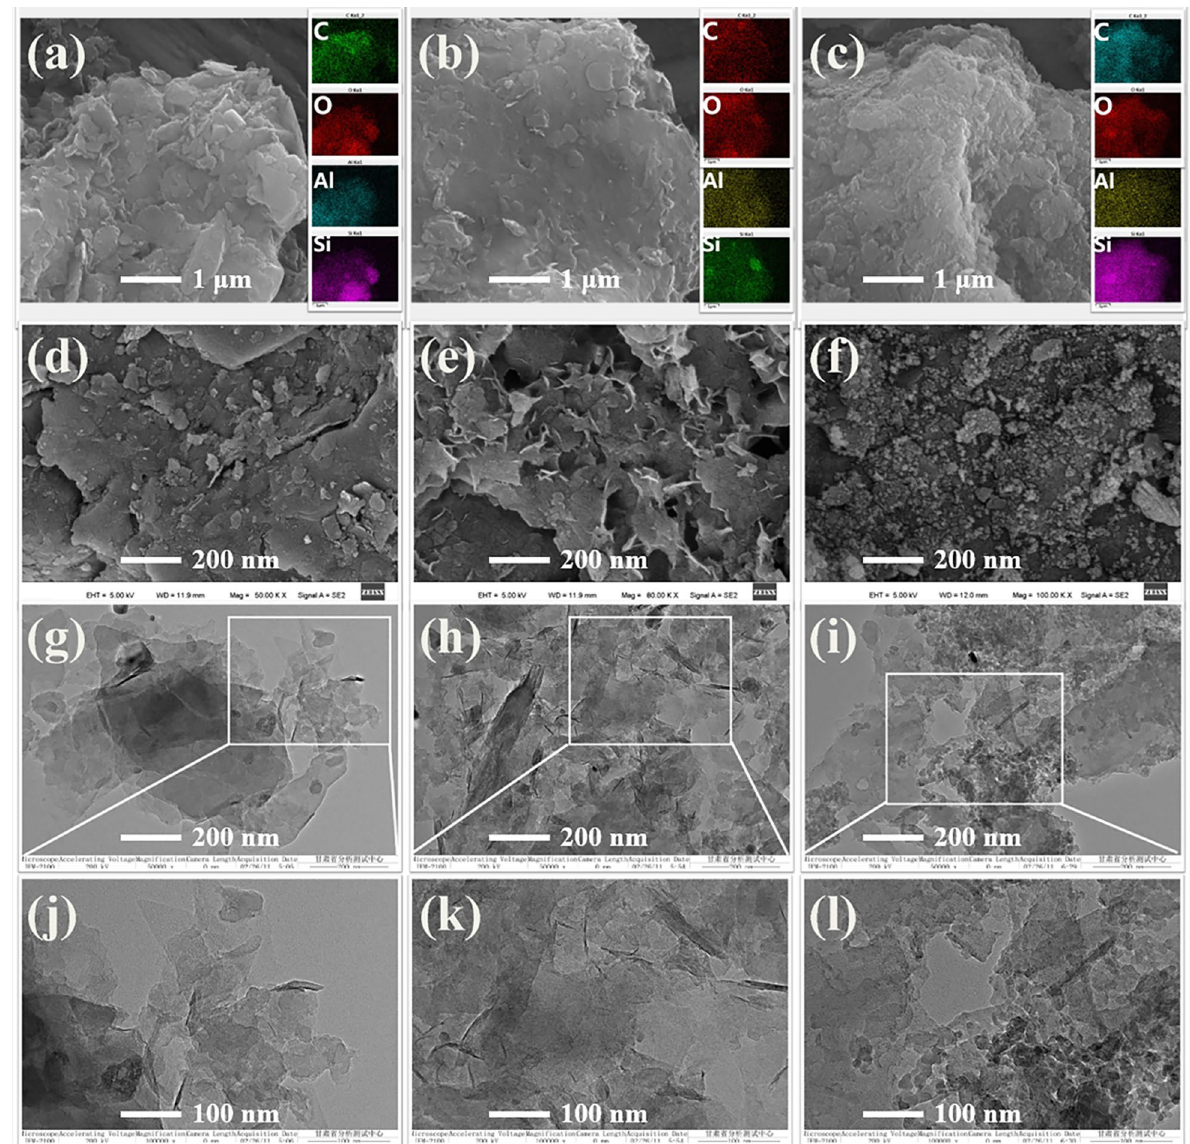
Fig. 3 SEM images, elemental mappings (the insets) and TEM images of OSSC ( a , d , g , j ), OSSC-0 ( b , e , h , k ) and OSSC-2 (c, f, i,